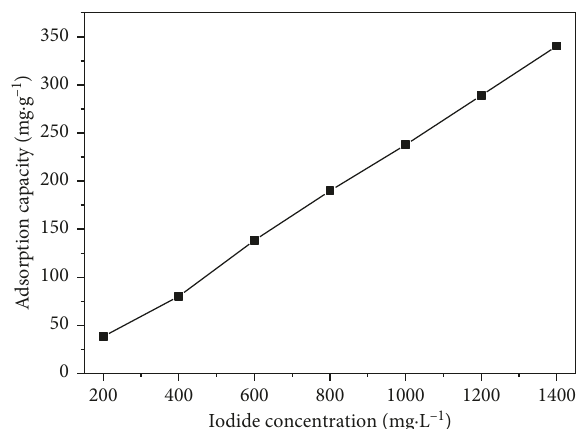
Figure 7: The curve of iodide adsorption capacity of Cu/Zn/Al-